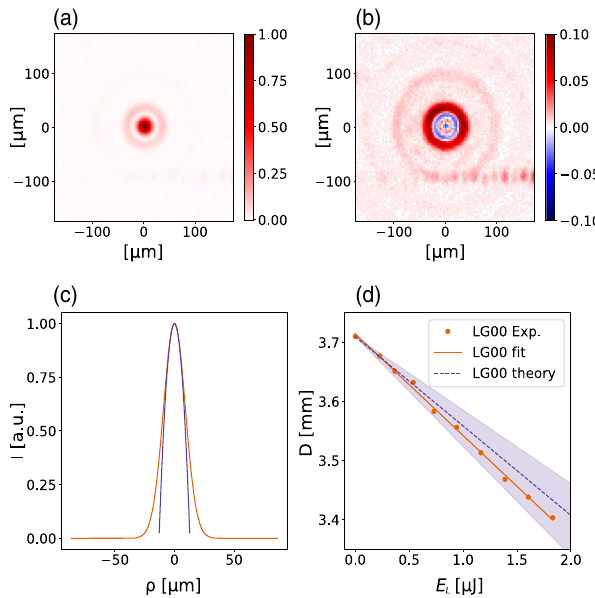
FIG. 10. (a) Spatial intensity distribution of the LG00 beam measured in the conjugate plane. (b) Residuals of a LG00 fit to the distribution. (c) Cross cut showing the fit (orange) and its quadratic Taylor expansion around ρ ¼ 0 (violet). (d) Diameter of the electron beam at the detector as a function of the laser pulse energy, along with the theory and an error region due to our error in determining the waist of the LG00